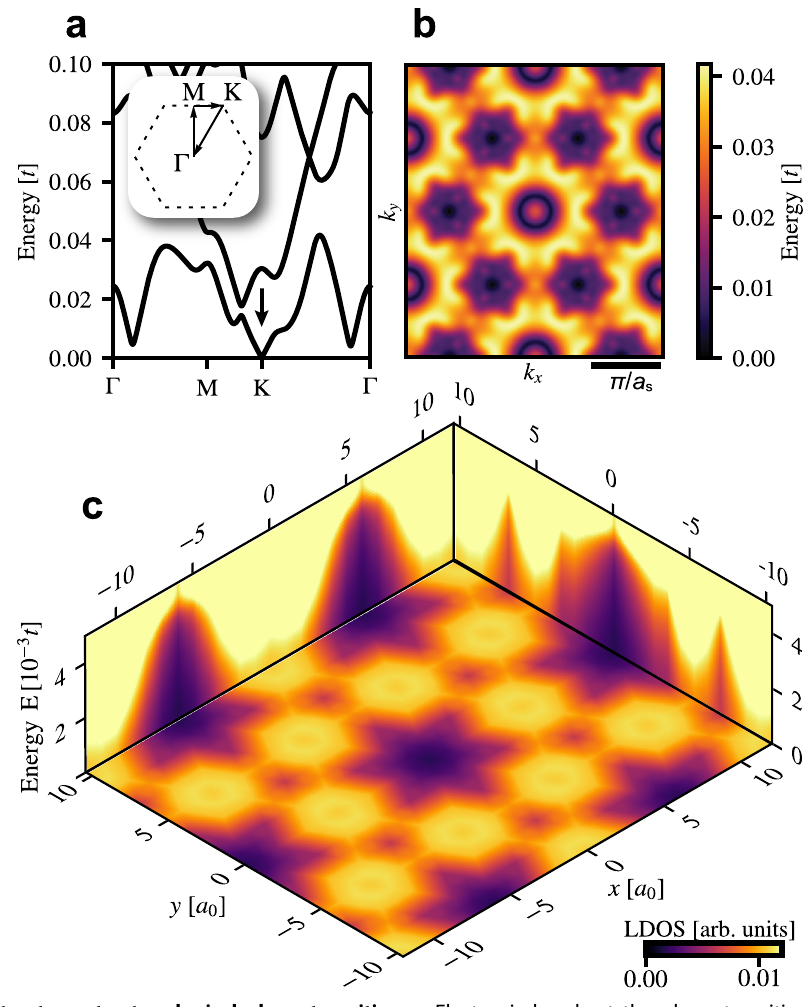
Fig. 3 Electronic band structure at a topological phase transition. a Electronic bands at the phase transition between two topological phases with C = 6 and C = 8 (as indicated by the solid black dot in Fig. 2c) for R = 6 a 0 and parameters ( μ , Δ , JS) = ( − 5, 0.4, 0.657) t . Shown is the Brillouin zone (BZ) of the skyrmion lattice, i.e., the reduced BZ (RBZ) of the underlying surface lattice. The position of the Dirac point is indicated by an arrow. b Spatial plot of the dispersion E k of the lowest energy band in the RBZ ( a s = 2 R is the lattice constant of the skyrmion lattice). c Spatial plot of the LDOS at the phase transition, as a function of position and